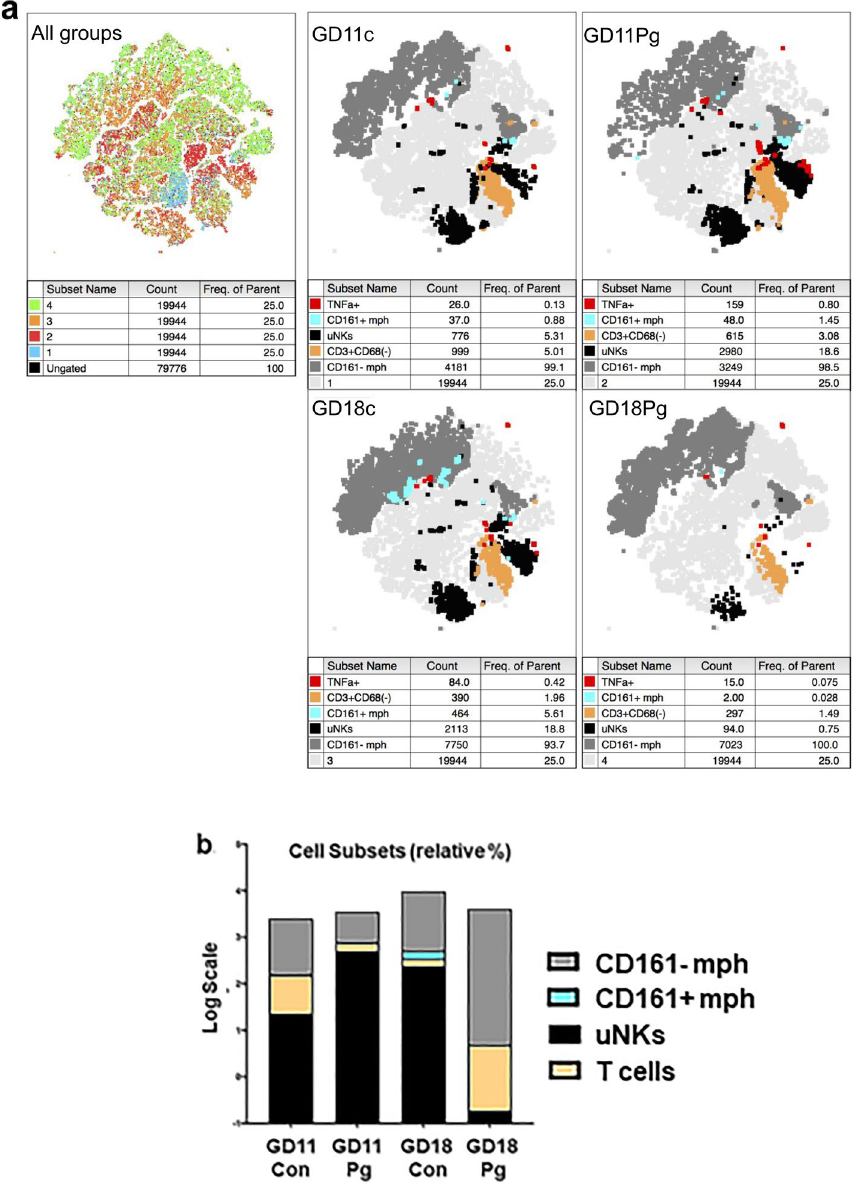
Figure 4. Overview of placental bed leukocyte populations identified by flow cytometry. ( a ) Clustering analysis by tSNE demonstrated population differences free of batch effects and identified corresponding immune cell populations in each treatment group. Processed datasets from all treatments (n = 4 per group) were analyzed with FlowJo’s t-SNE and Flow Means plug-in (FlowJo v10.6.2, Treestar, Ashland, OR). ( b ) Bar chart shows relative proportion of each immune cell subset included in the analysis. Individual populations are shown in supplement file, Fig.